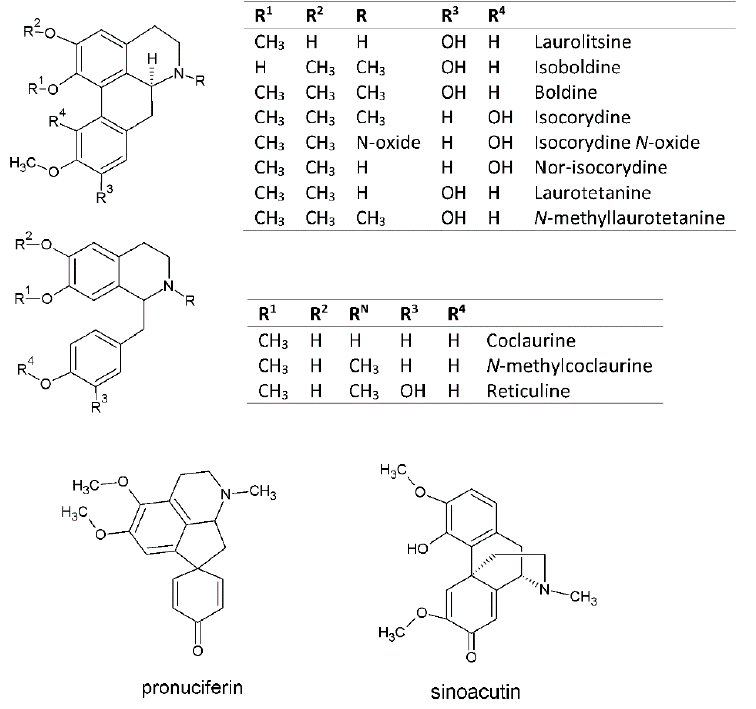
Figure 1. Structure of main alkaloids identified from Peumus boldus leaves.